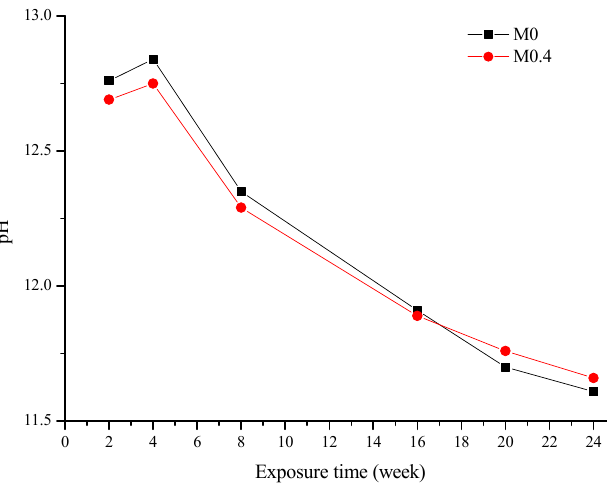
Figure 2. pH of the used solution at various ages. Since XRD patterns of the slags and AAMs before and after exposure did not show any crystalline phases (not shown for the sake of brevity), FTIR was chosen to investigate the influence of MgO/(MgO + CaO) on sulfate resistance. Figure 3a illustrates the FTIR spectra of AAMs unexposed and exposed to sulfate solution. There are no clear changes, such as new or disappearing bands, when comparing AAMs before and after exposure to the sulfate solution, which indicates that the silicate network is not significantly altered. A zoomed ‐ in spectrum focused on the Si–O stretching band (1200–700 cm − 1 ), Figure 3b, enables a more detailed analysis. After exposure, the maximum of the main band slightly shifted to a lower wavenumber and the extent of the shifting is more obvious for M0.4 (from 986 to 974 cm − 1 ) than M0 (from 978 to 976 cm − 1 ). The main change in both AAMs is broadening of the band, seemingly caused by the appearance of a shoulder at the two sides of the band. The signals are broad and, thus, confirm that the presence of crystalline precipitates is unlikely. The high wavenumber shoulder around 1100 cm − 1 indicates the presence of sulfates [9]. The low wavenumber shoulder (850–900 cm − 1 ) cannot be explained by the presence of sulfates. Other possible explanations are (1) the incorporation of additional Na in the silicate network; therefore, increase in network modifying cations or (2) a more drastic reconfiguration of the binding phases due to the change in pH of the pore solution.